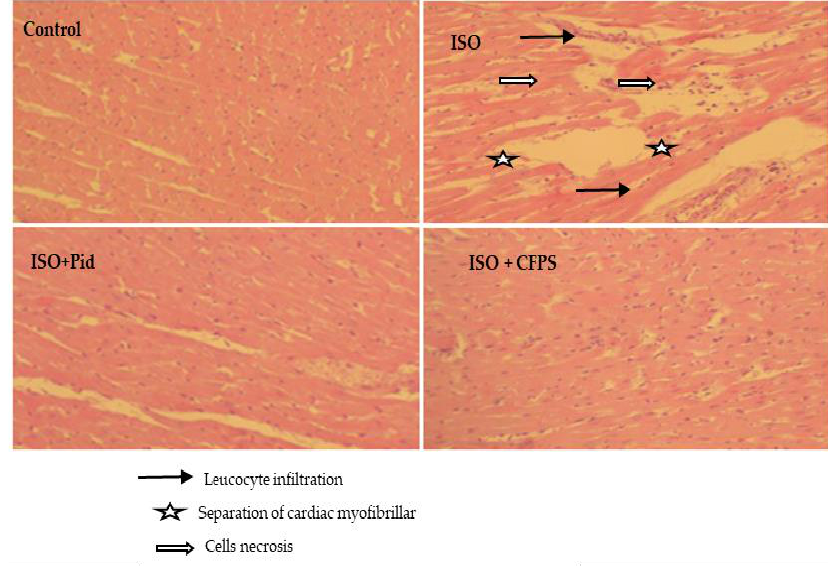
Figure 8. Effect of CFPS precotreatment on histology of myocardial tissue.